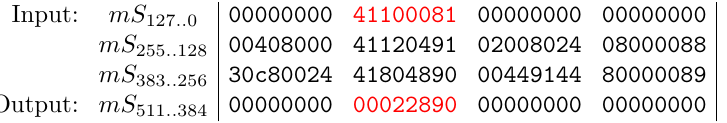
Table 14: Bias 2 − 41 optimal linear trail for 384 rounds found with the refined model. The mask on the input and output data block can only be active on the second most significant 32-bit word. Those are stressed by red. Information of the intermediate masks is provided to recover all linear approximation